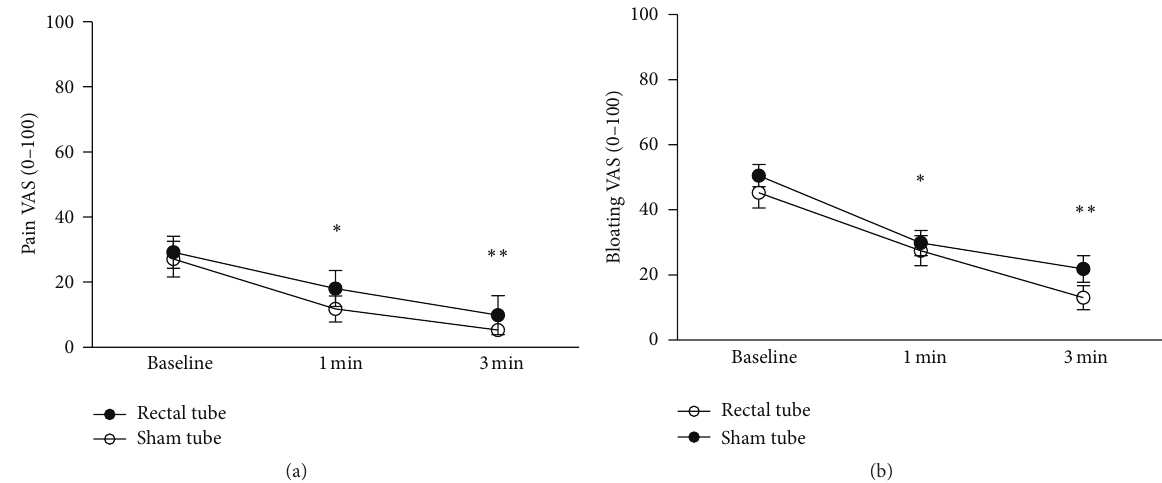
Figure 1: Abdominal symptoms after placement of rectal tube (a) and sham tube (b). After both treatments, abdominal pain and bloating significantly improved at 1min and 3 min when compared with the baseline. ∗ 𝑃 < 0.05 , 1 min versus the baseline; ∗∗ 𝑃 < 0.05 , 3 min versus the baseline. Values are expressed as mean ± SEM.